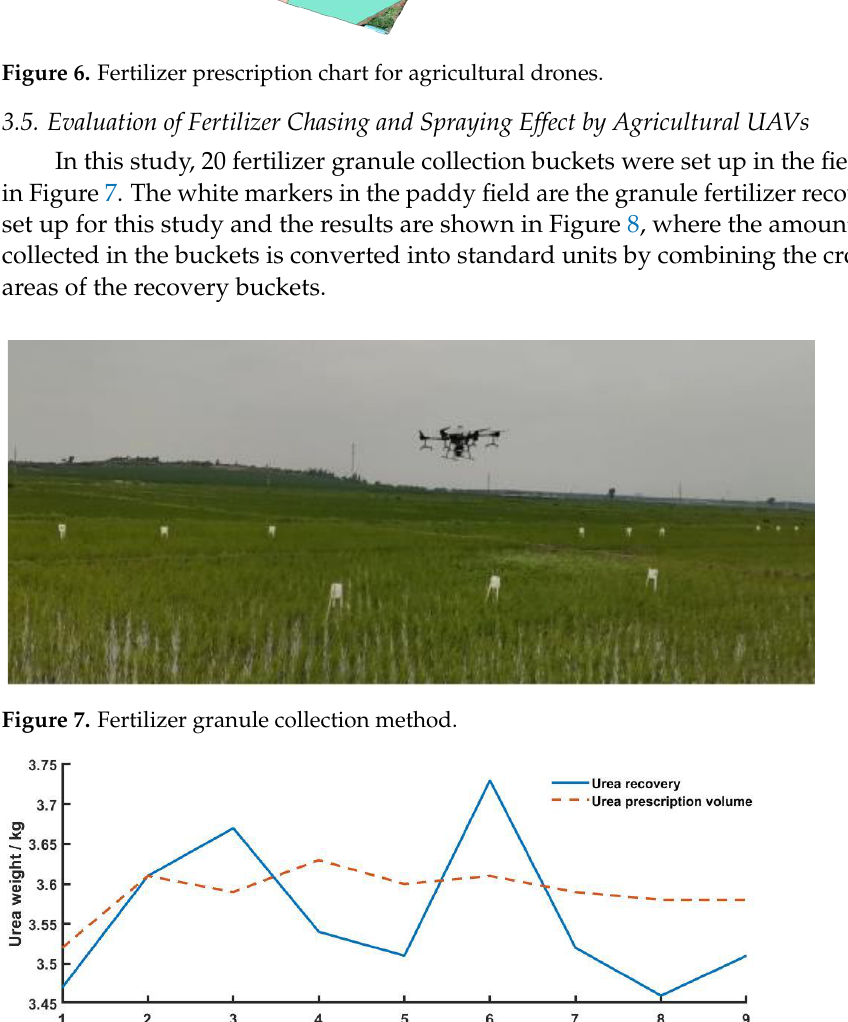
Figure 6. Fertilizer prescription chart for agricultural drones.